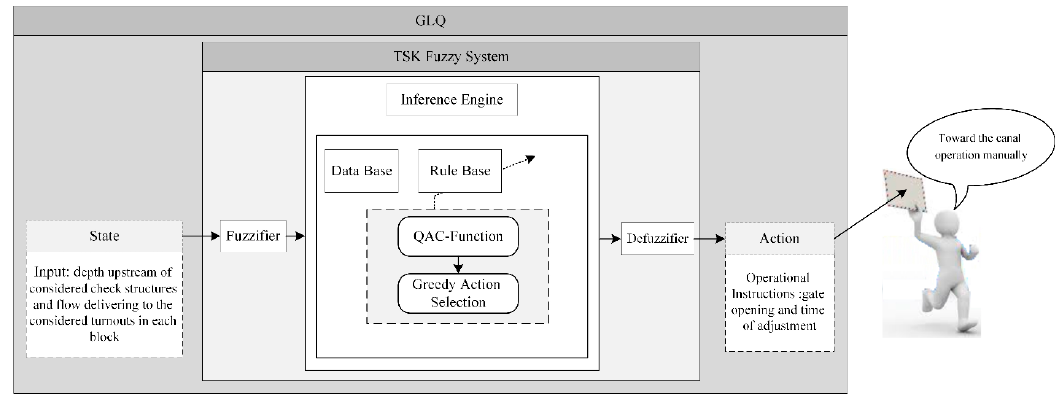
Figure 5. The developed generalizing learned Q-function (GLQ) model architecture.